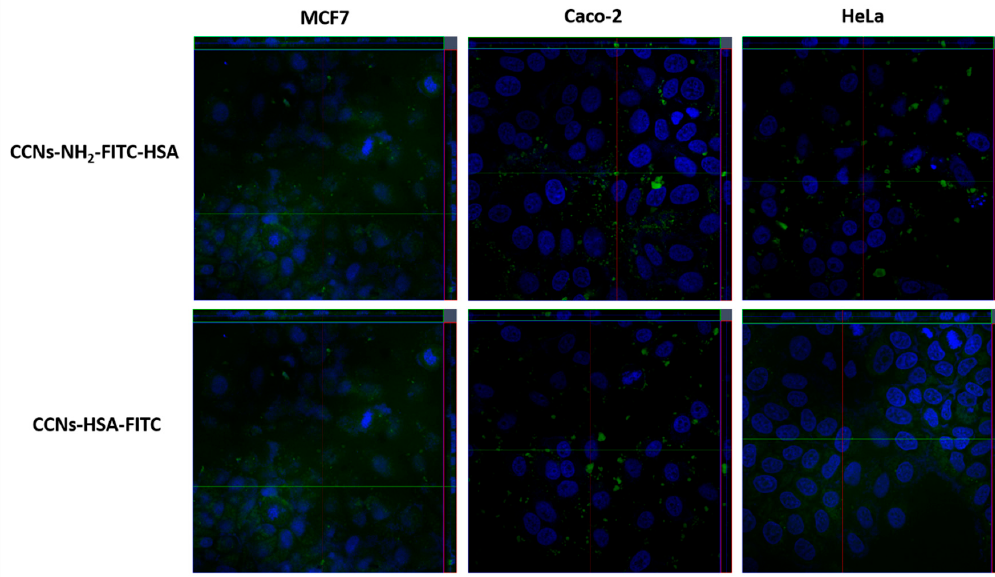
Figure 6. Z-Stack confocal microscopy images showing cellular uptake of CCNs-NH 2 -FITC HSA (first line) and CCNs-HSA-FITC (second line) by MCF7, HeLa and Caco-2 cells. The nucleus was stained by using Hoechst 33342 (blue) after cells fixation. A FITC filter responding to the green fluorescence employed to recognize the location of FITC conjugated CCNs.